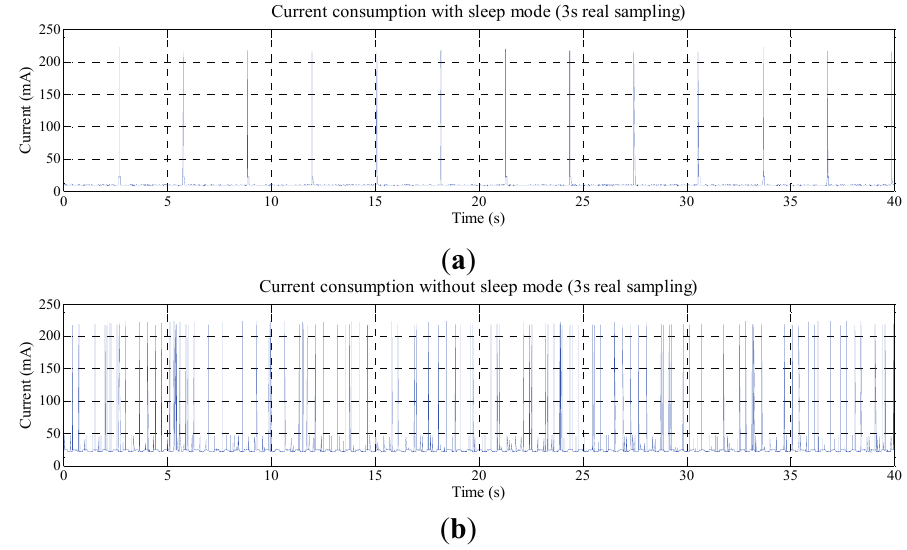
Figure 10. Current consumption during WNCS operation WNCS operation with sampling rate of 3 s ( a ) XBee module using sleep mode; ( b ) XBee module not using sleep mode.